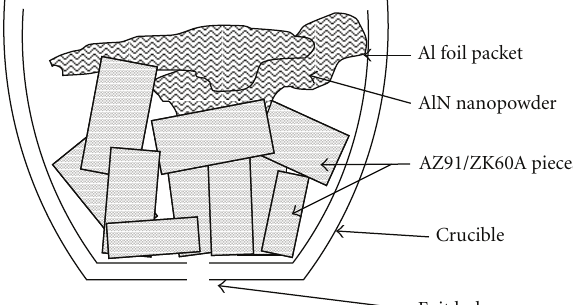
Figure 1: Arrangement of raw materials in crucible before casting for AZ91/ZK60A/AlN